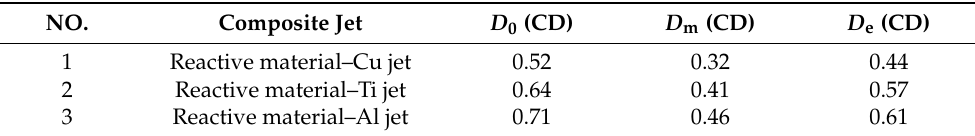
Figure 6. The diameter parameters of penetrated steel targets. Table 1. Experimental results of penetration hole diameters under different reactive material composite jets against steel targets.